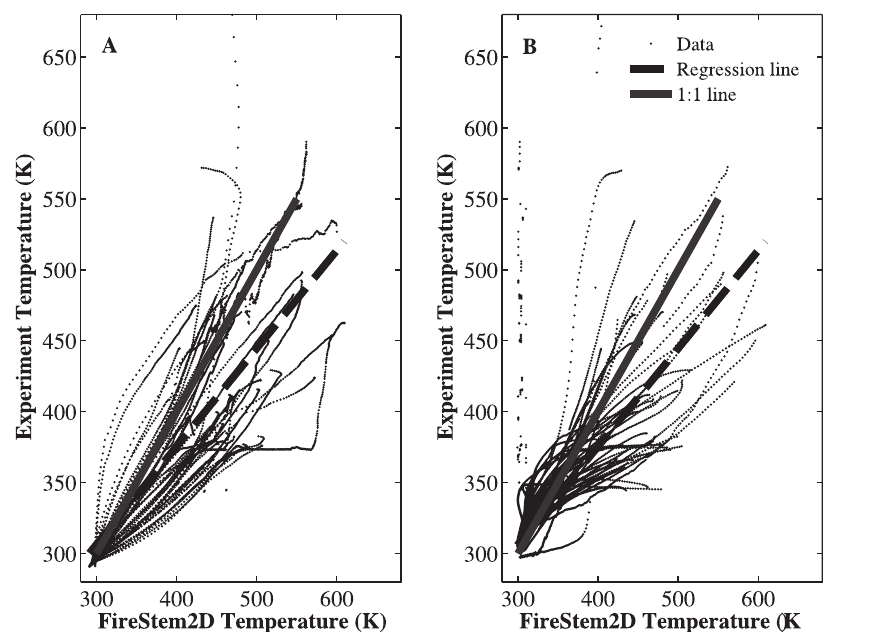
Figure 4. Scatter-plots of measured time series of temperature at a single point (at cambium, at a depth of 1 to 5 cm into the stem) for 52 tree sections collected from 25 trees of 8 different species (table 1). A. Heat-up phase (regression line: y=0.6907( 6 0.013)x + 96( 6 2.1801), R 2 =0.61). B. Cool-down phase (regression line: y=0.6946( 6 0.0043)x + 100.6409( 6 1.3906), R 2 =0.64). Dashed lines mark the overall model-observation fit, solid lines mark the ideal (1:1) model-observation relationship. FireStem2D predicts the temporal dynamics of temperature in the cambium well, although it slightly overestimates the peak temperatures.